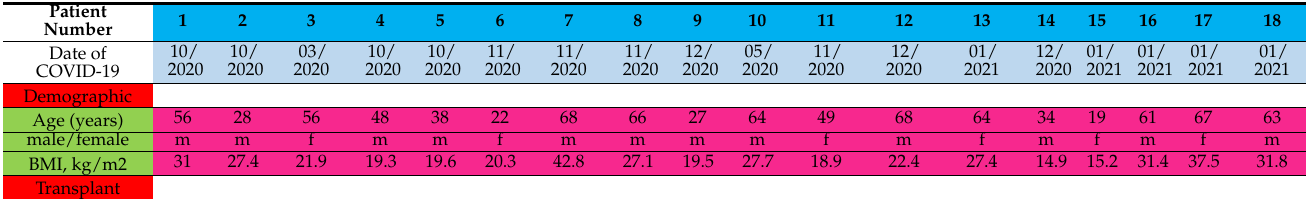
Table 4. Patient characteristics, treatments and